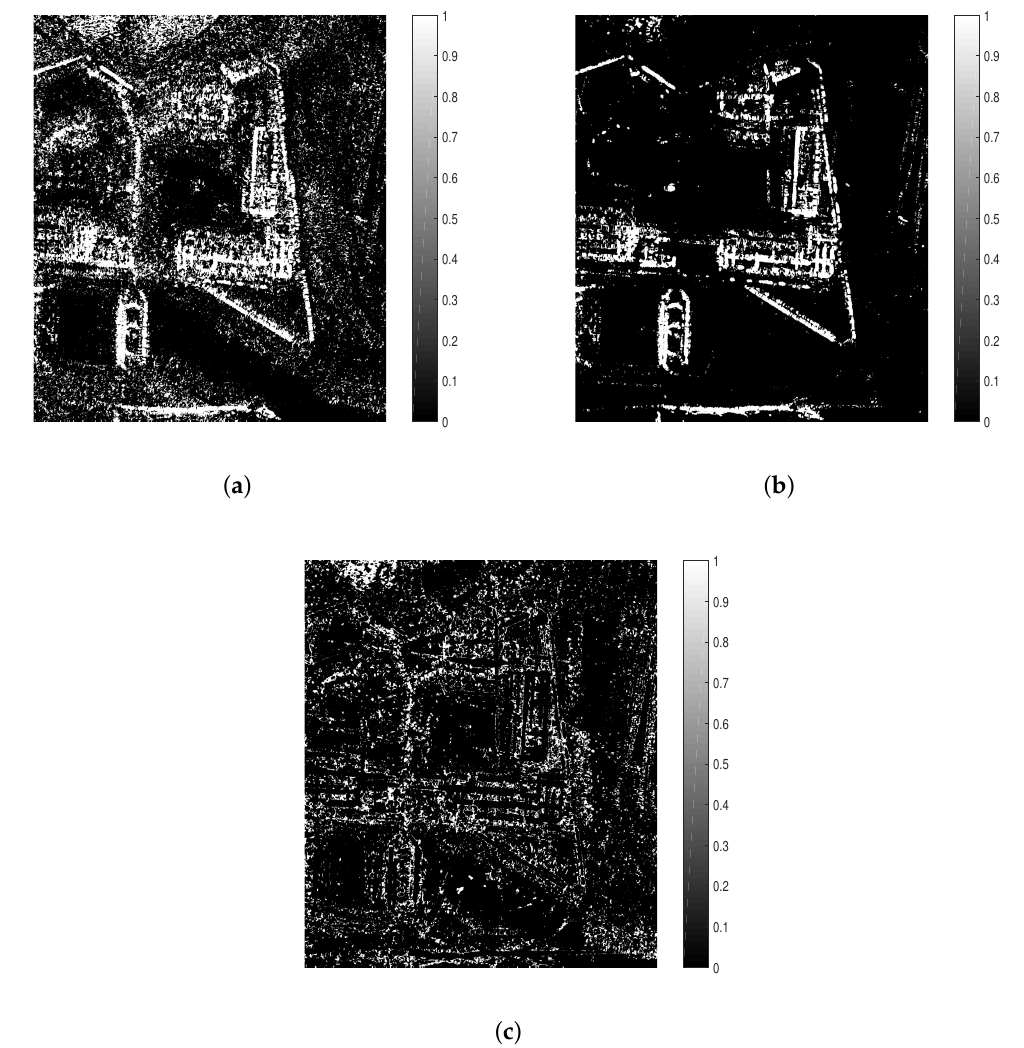
Figure 13. ( a ) Dihedral scattering identified by H- α ; ( b ) anisotropic dihedral scattering; and ( c ) isotropic dihedral scattering identified by MAPE and α